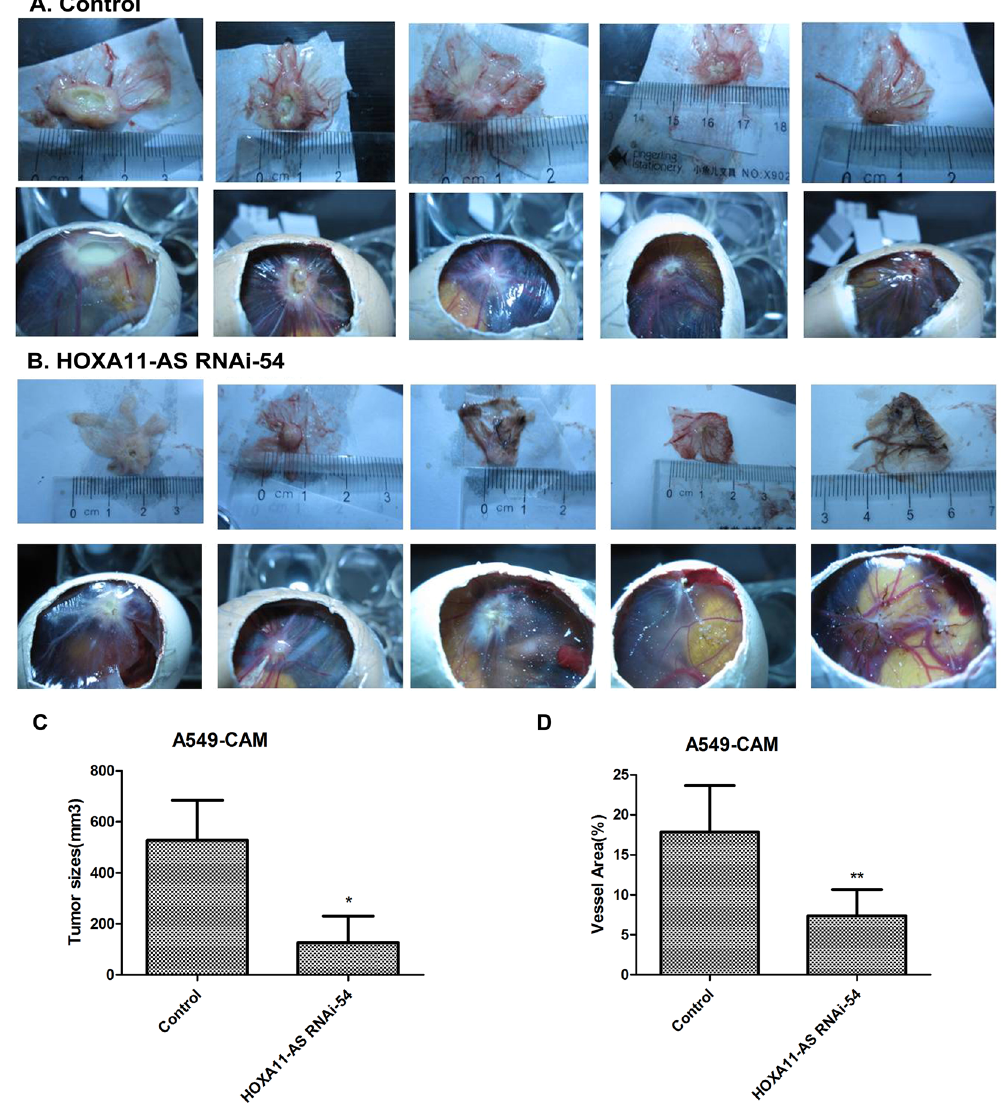
Figure 11. The A549 cell tumor formation in the chick chorioallantoic membrane after transfecting A549 cells with HOXA11-AS RNAi. ( A ) Lenti-control virus group. ( B ) HOXA11-AS RNAi-54 group. ( C ) Comparison of the size of the A549 cell tumor xenografts after silencing HOXA11-AS expression ( * P < 0.05). ( D ) Comparison of the vascular area ratio of the A549 cell tumor xenografts after silencing HOXA11-AS expression ( ** P <